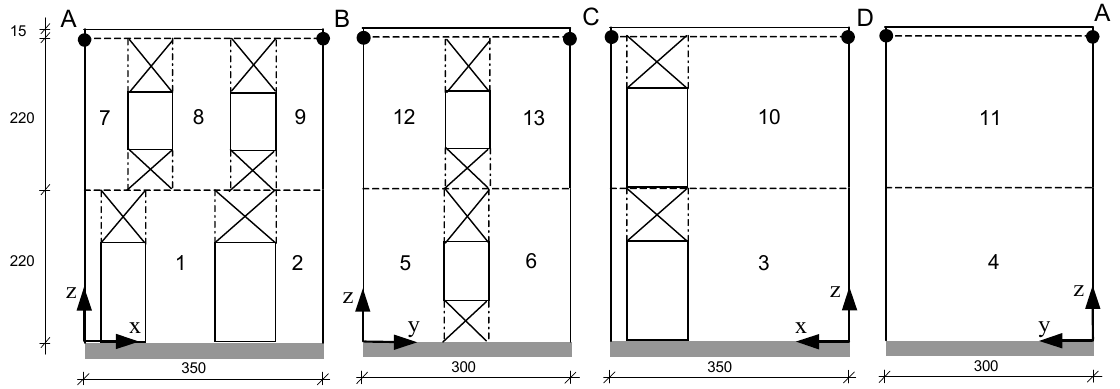
Figure 11. Macro-element (ME) model: definition and numbering of the